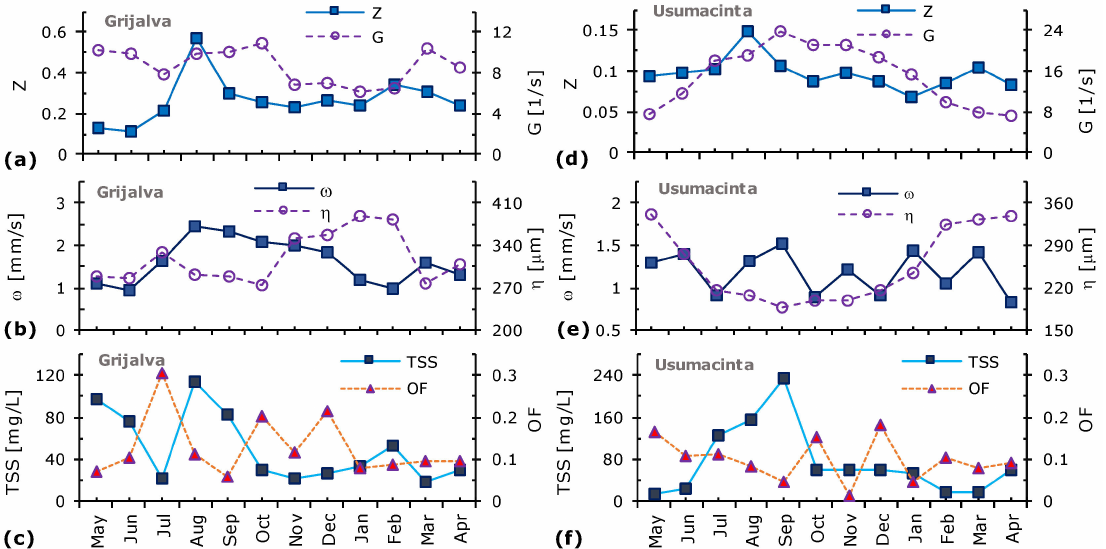
Figure 9. Intra-annual variability in Rouse parameters: ( a , d ) Rouse number (Z) vs. shear rate (G); ( b , e ) Effective settling velocity ( ω ) vs. Kolmogorov microscale ( η ); ( c , f ) Mean total suspended solids (TSS) and organic fraction